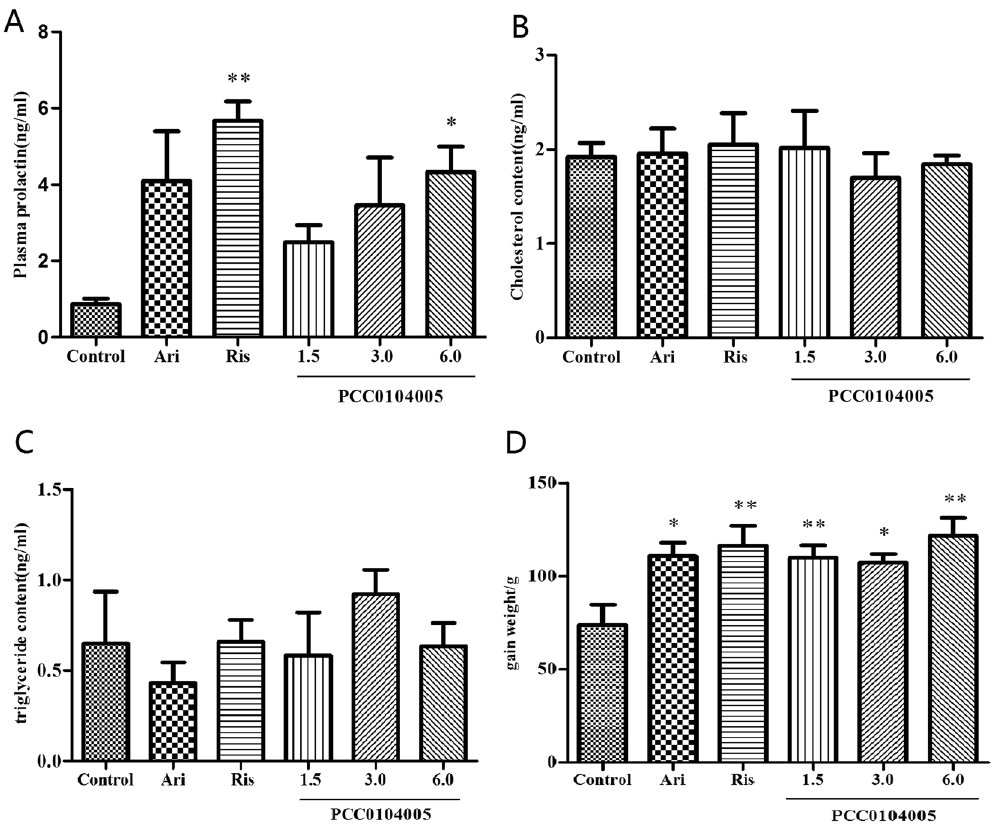
Figure 8. The adverse reactions that may be caused by PCC0104005. Rats were administered vehicle alone, PCC0104005 (1.5, 3.0, or 6.0 mg/kg), aripiprazole (Ari, 1.5 mg/kg, i.g.) or risperidone (Ris, 0.2 mg/kg) for 28 days before testing. Results are presented as mean ± S.E.M. (n = 3–5). ( A ) Plasma prolactin levels in different groups. Plasma prolactin levels were assessed using a commercially available Prolactin ELISA Kit. * P < 0.05, ** P < 0.01 drug delivery groups vs. the control group. ( B , C ) Plasma total cholesterol and triglyceride levels in different groups. ( D ) Weight changes in different groups. * P < 0.05, ** P < 0.01 drug delivery groups vs. the control